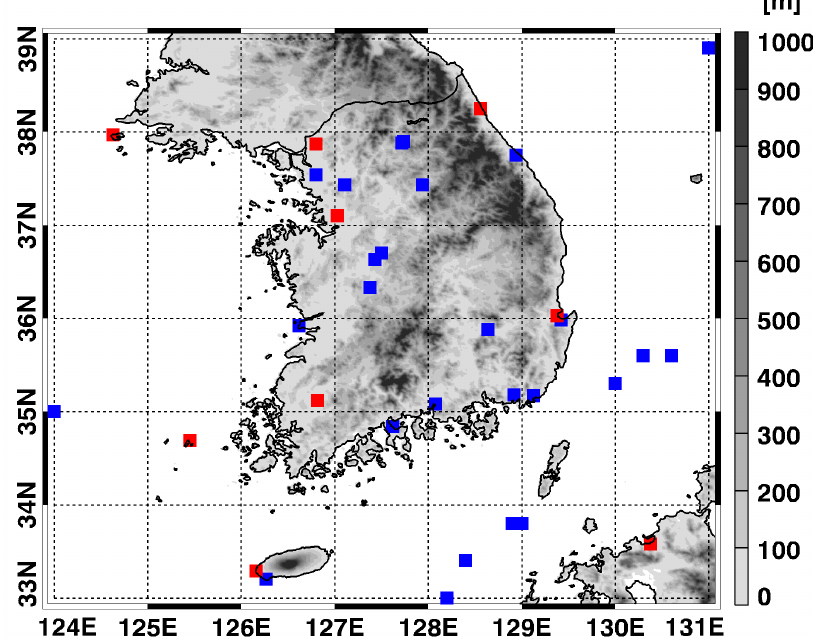
Figure 1. Location of radiosonde stations over Korea (gray contours represent topography and the red squares indicate stations from which over 1000 soundings were conducted).